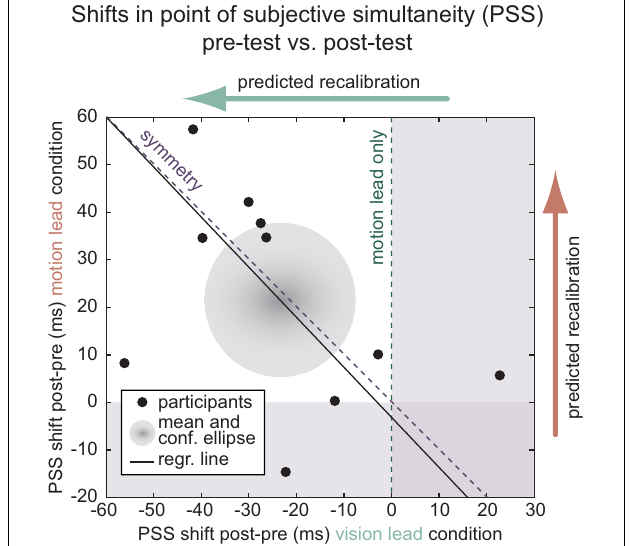
FIGURE 4 | Recalibration results. Individual participants (black dots); group mean and confidence ellipse and regression line (black). Recalibration was observed in both the vision-lead and movement-lead conditions (confidence ellipse in white quadrant) and it was not biased to either side of the inverse diagonal representing symmetry of recalibration